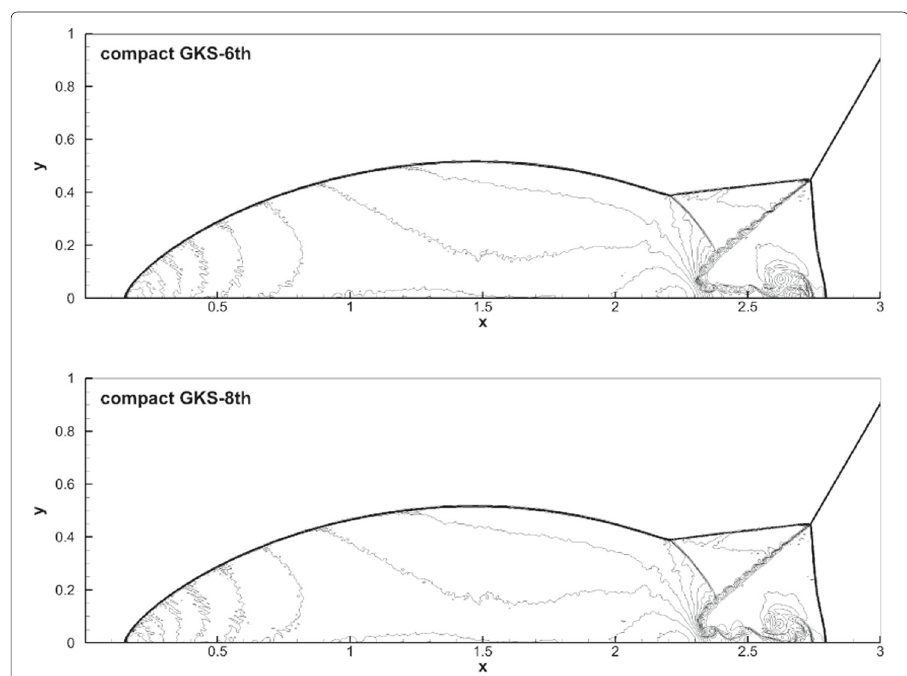
Fig. 12 Double Mach reflection: the density contours of 6th-order and 8th-order compact GKS with 960 × 240 mesh points